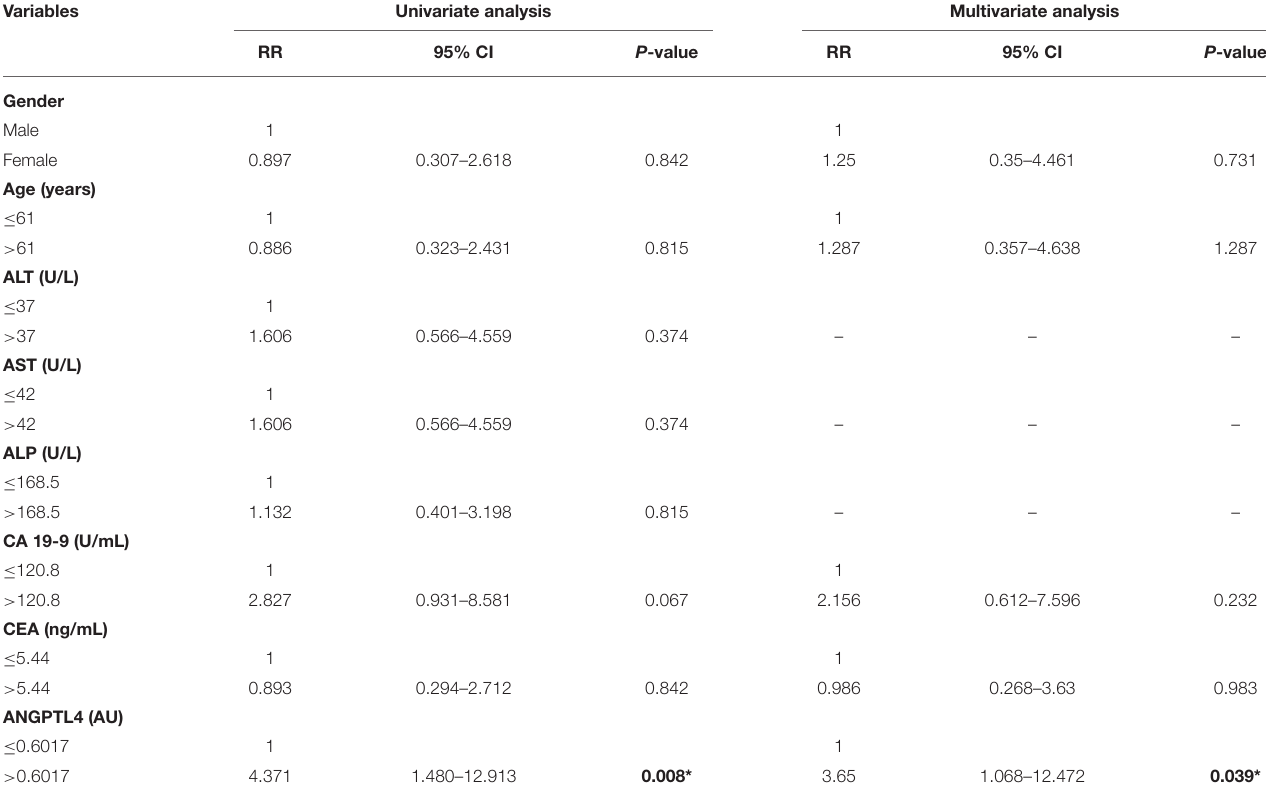
TABLE 5 | Univariate and multivariate regression analysis of clinical parameters associated with lymph node metastasis.